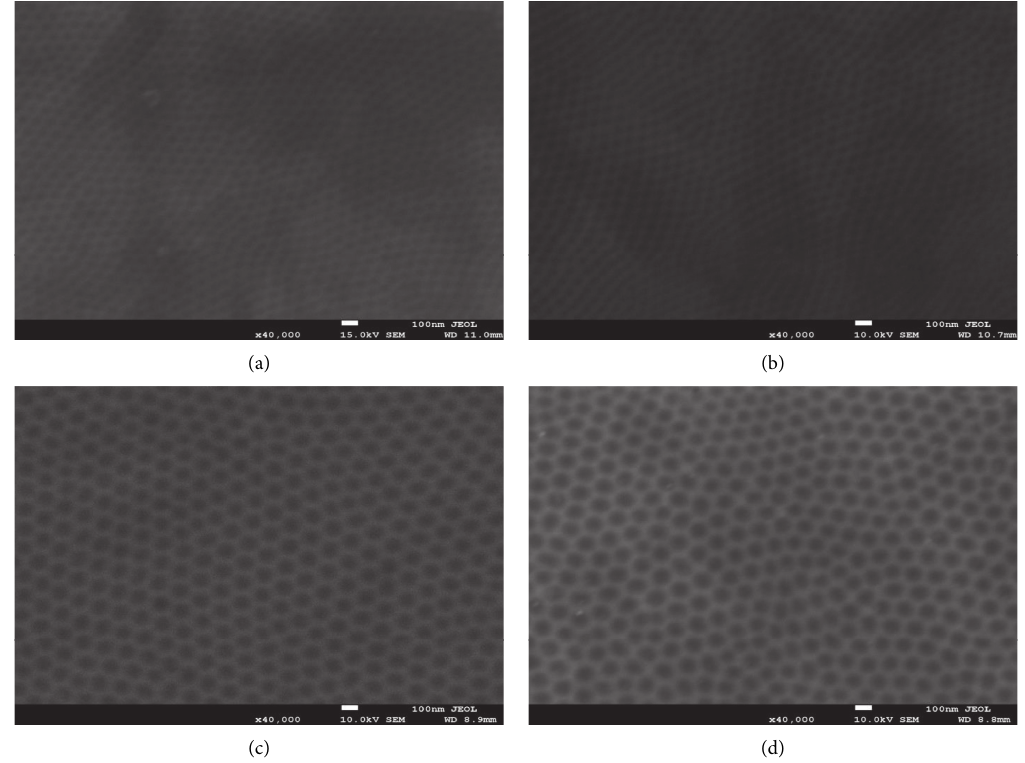
Figure 3: SEM images of stainless steel samples anodized under different load voltages: (a) 20V, (b) 30V, (c) 40 V, and (d) 50 V.